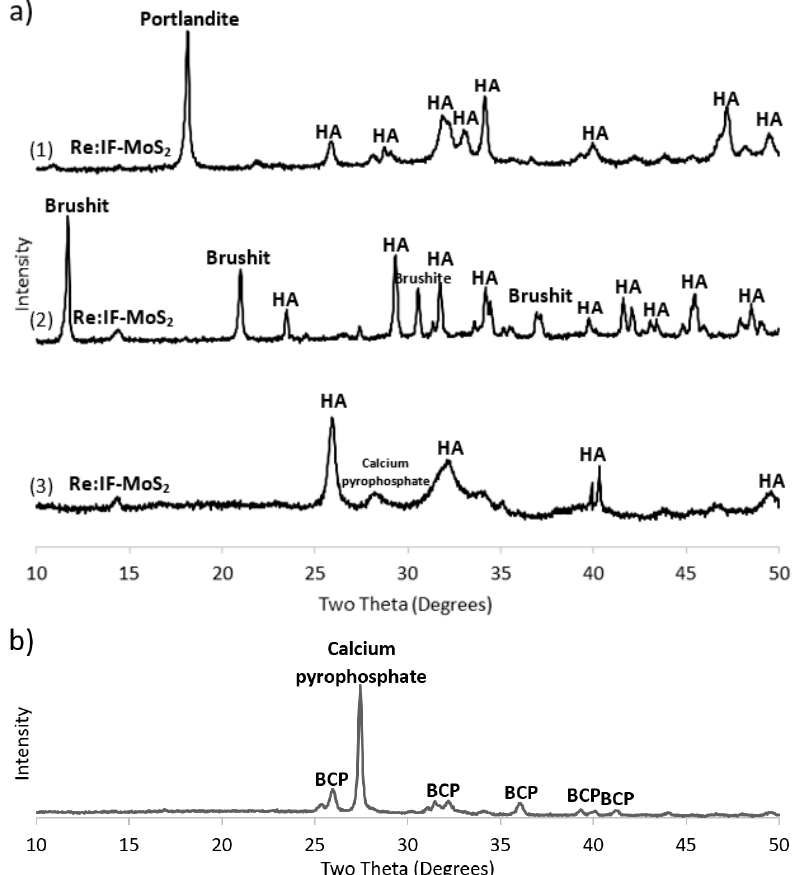
Figure 5. ( a ) XRD patterns of the HA films incorporating Re:IF-MoS 2 nanoparticles: film obtained from solution A (1), solution B (2) and solution C (3); ( b ) shows the XRD pattern of the film obtained from solution A (3 h) after annealing (700 °C for 1 h). Here, a strong crystalline peak associated with calcium pyrophosphate phase (Ca 2 (P 2 O 7 )) is observed. This phase is obtained through water